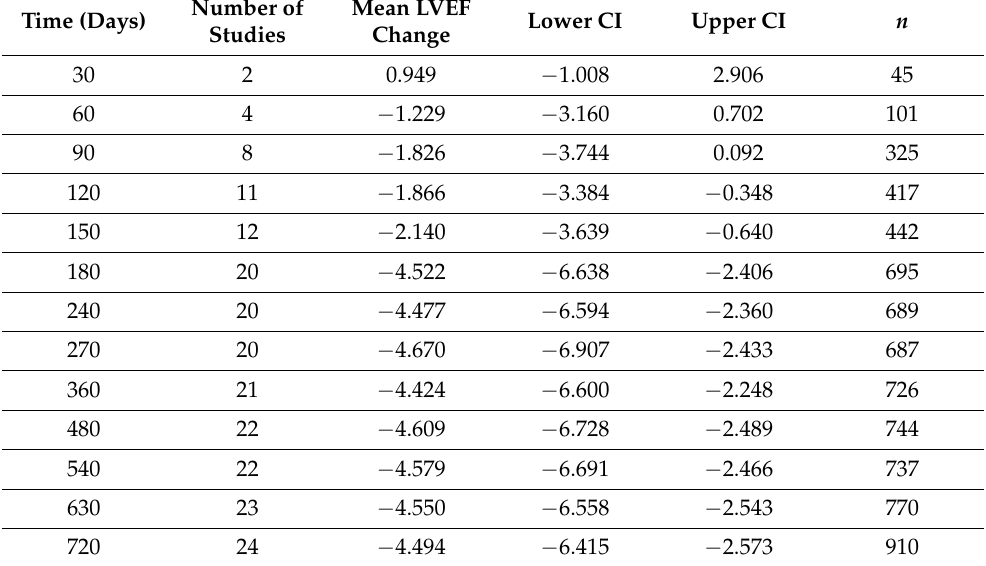
Table 1. Cumulative decline in left ventricular ejection fraction (%) over time